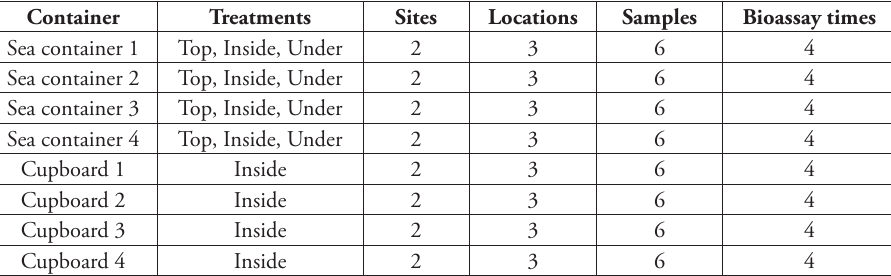
Table 1. Summary of soil samples, treatments and assays to investigate survival of soil biota (bacteria, fungi, nematodes and